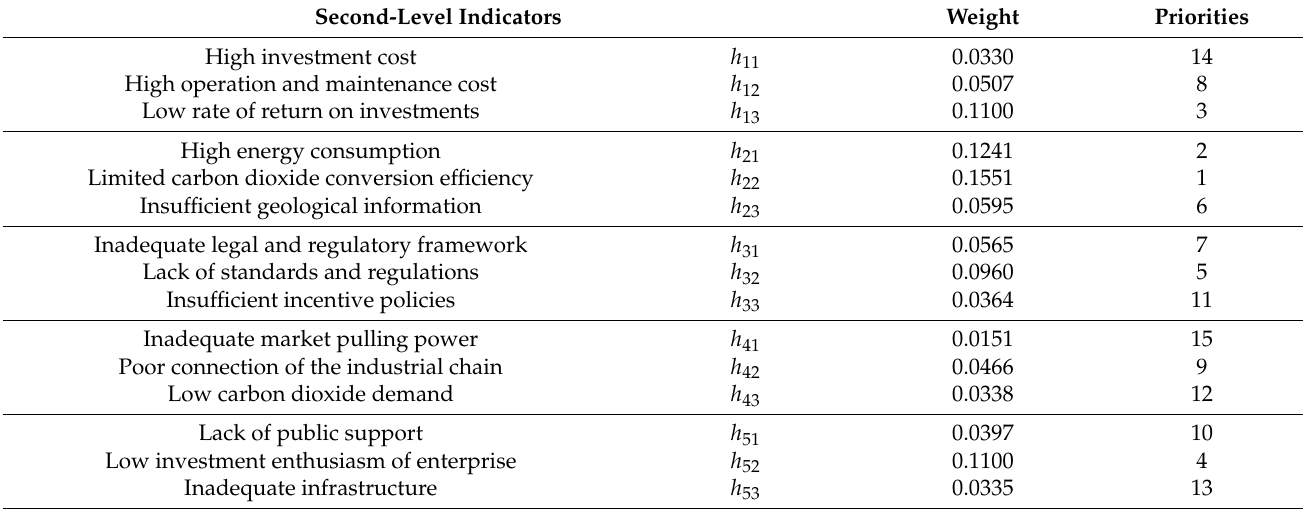
Table 3. Weight coefficients of the second-level